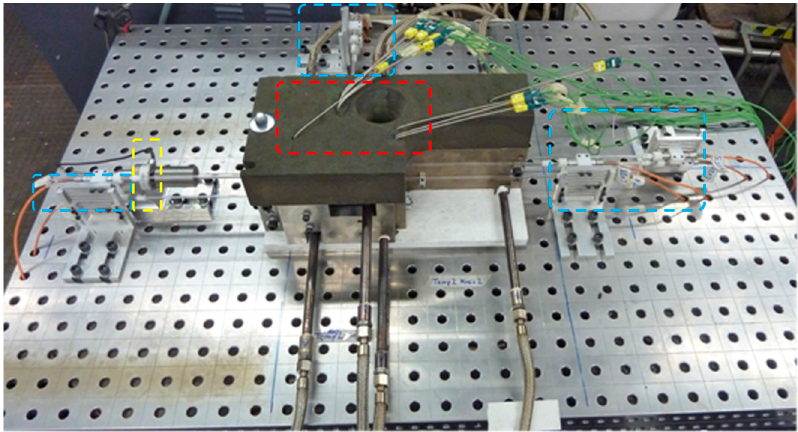
inlet are the coldest. Figure 6. Complete test setup prepared for the first test. The temperature measuring points (red), the displacement transducers (blue), and the load cell (yellow) are clearly visible.